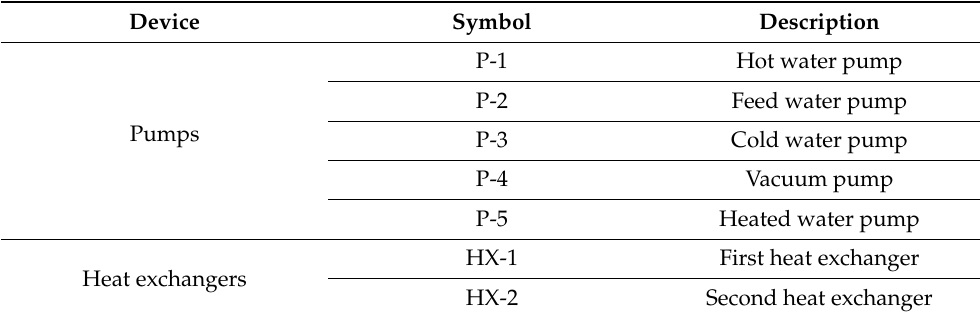
Table 2. Abbreviations of the V-MEMD